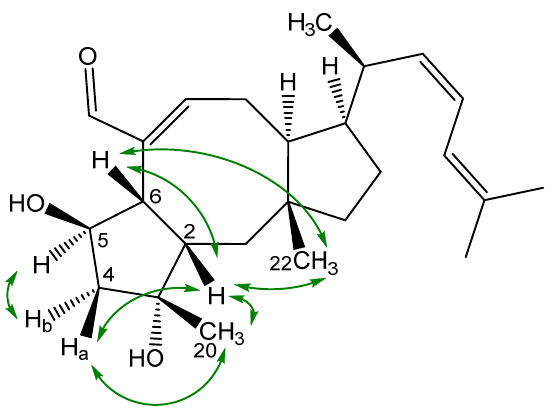
Figure 11. Important NOE correlations in ophiobolin